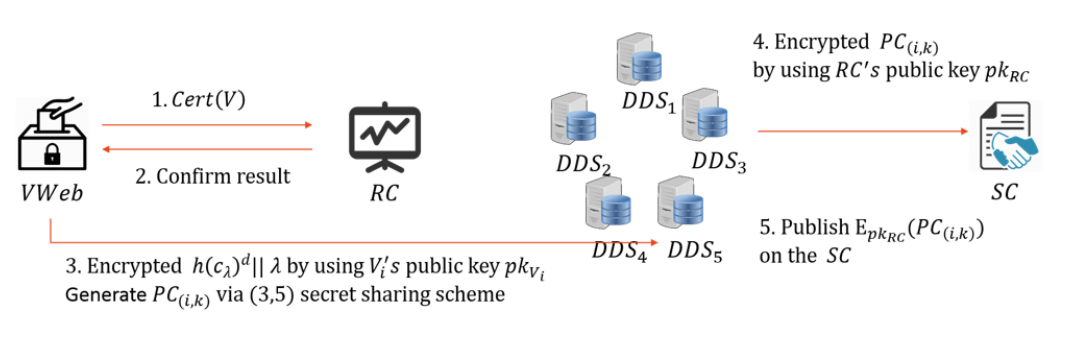
Figure 4. Polling